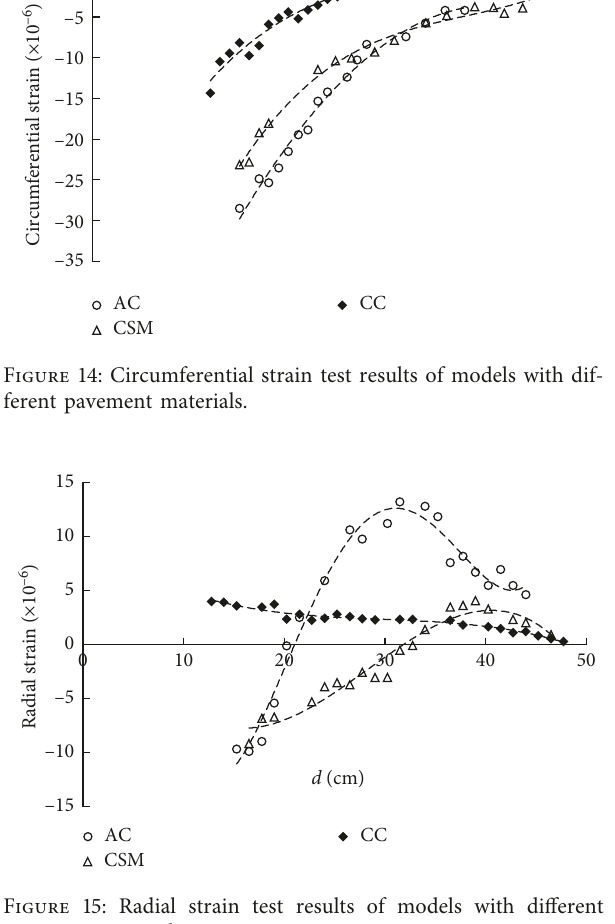
Figure 15: Radial strain test results of models with different pavement